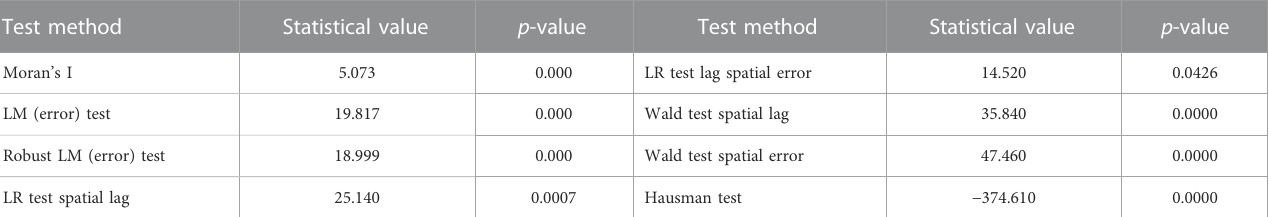
TABLE 4 Spatial model tests. Test method